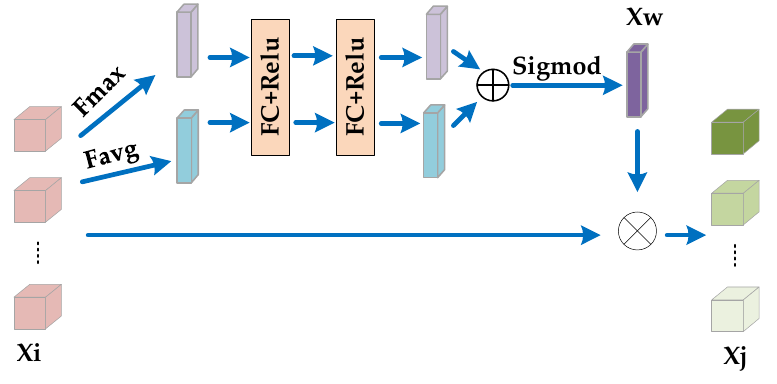
Figure 12. Feature attention module.